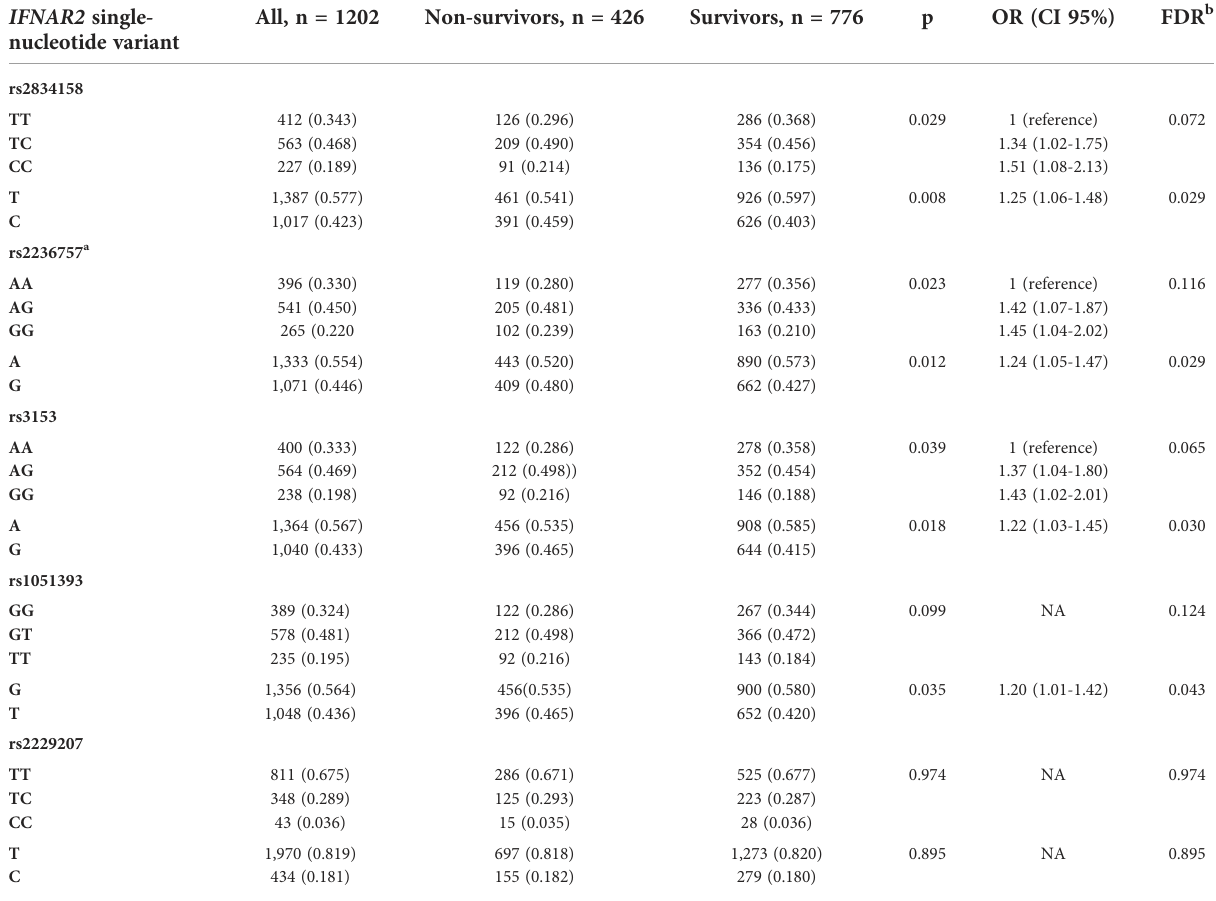
TABLE 2 Genetic association study of IFNAR2 variants with mortality in patients with severe COVID-19. IFNAR2 single-